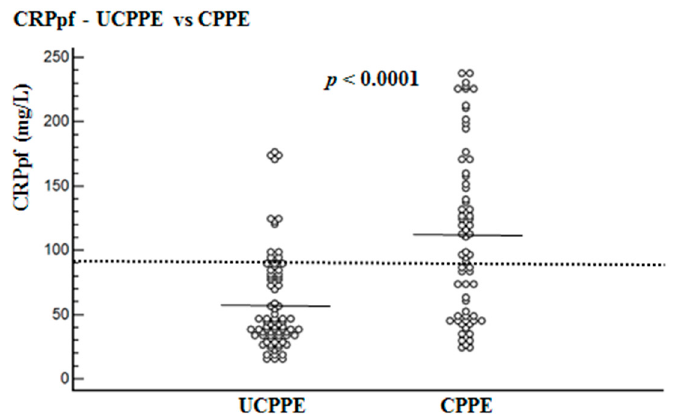
Figure 1. Serum CRP levels (CRPs), and their means for uncomplicated parapneumonic effusion (UCPPE) group (145.3 mg/L) and complicated parapneumonic effusion (CPPE) group (302.2 mg/L, and best cut-off value (211.5 mg/L) for discrimination between UCPPE and CPPE. For both parameters p < 0.0001.